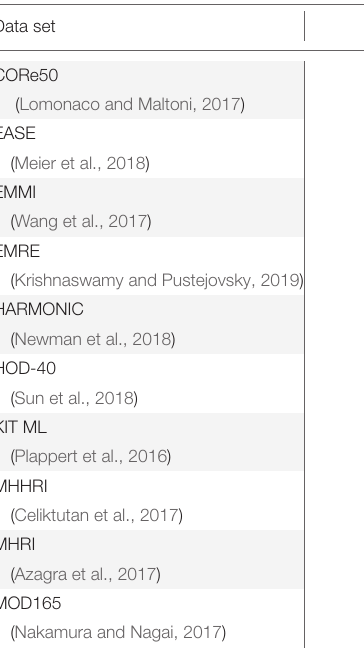
TABLE A1 | Related multimodal and/or developmental data